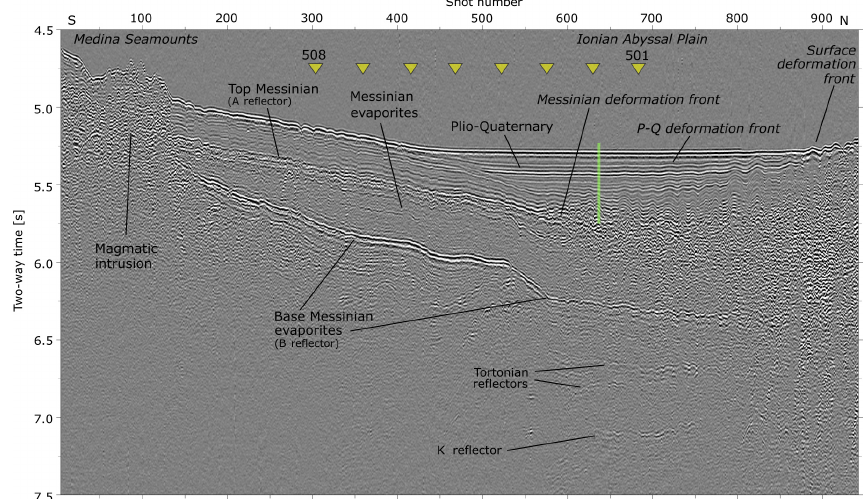
Figure 2. Stacked and bandpass-filtered ( f = 20, 30, 80, 120Hz) multi-channel data (MCS) along profile DY-05. Yellow triangles mark the OBS locations along the MCS profile. Green bar marks the projected location of DSDP site 374 on the profile